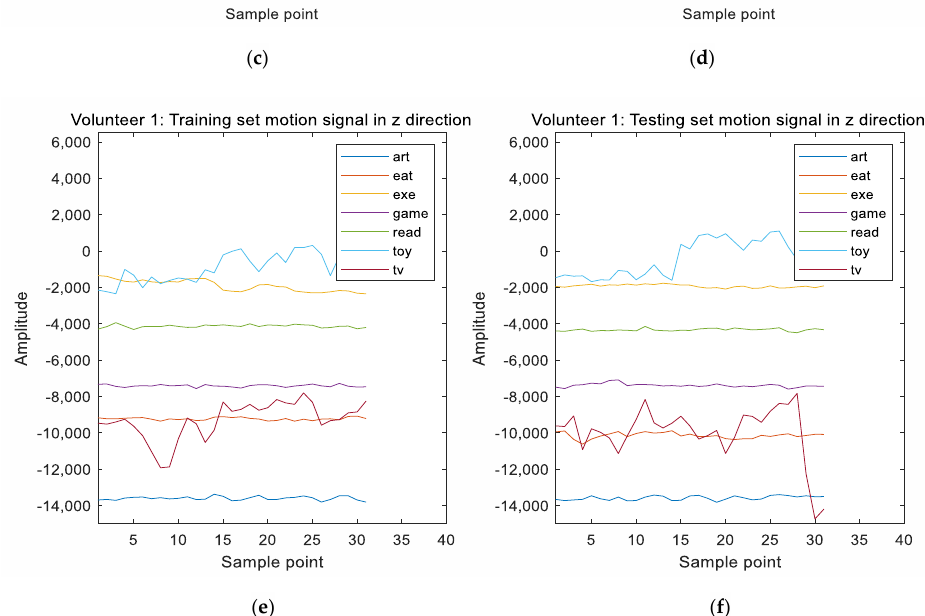
that of the sensory motor rhythm (SMR) wave is between 12 and 14.99 Hz, that of the mid-β wave is between 15 and 19.99 Hz, that of the high-β wave is between 20 and 30 Hz, that of the low-β wave is between 12 and 19 Hz, that of the whole-β wave is between 12 and 30 Hz, and that of the γ wave is between 30 and 49 Hz. To extract these waves from the electroencephalograms, the fast Fourier transform approach is employed. That is, the fast Fourier transform coefficients of the electroencephalograms are computed and the coefficients outside the corresponding frequency bands are set to zero. Then, the inverse fast Fourier transform is computed to obtain the corresponding waves. It can be seen from the above that this approach does not introduce nonlinear phase distortion.